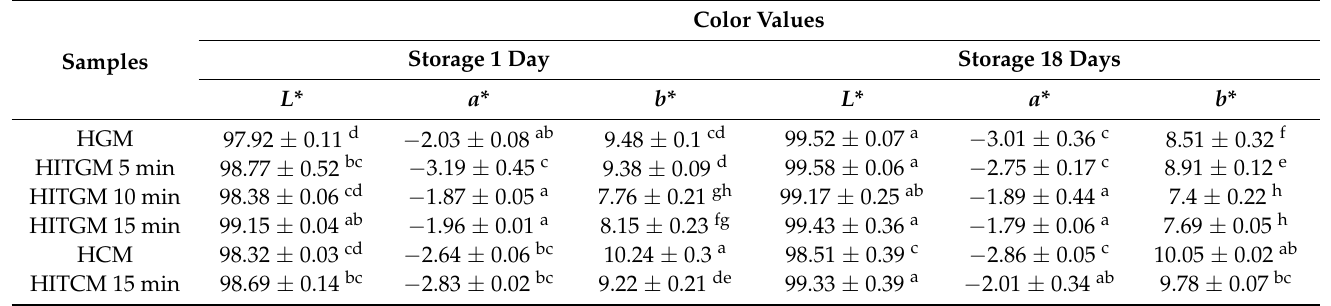
Table 2. Color values of stirred yoghurt samples on the first and 18th day of storage ( n = 12).